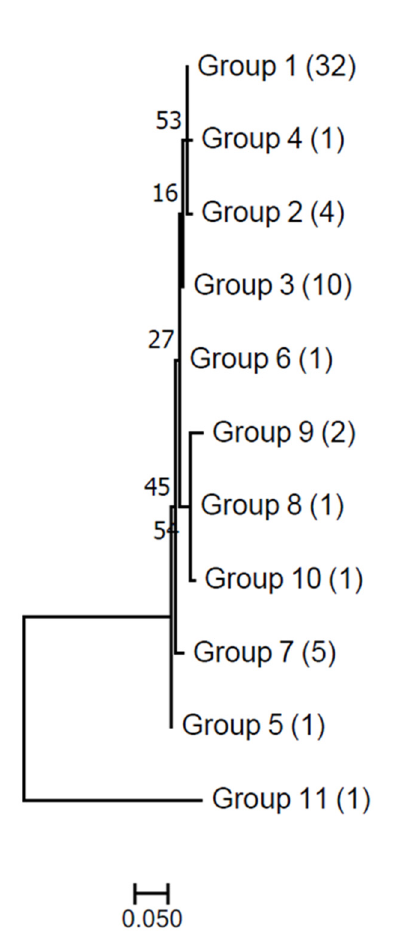
Figure 2. Phylogenetic tree of SASA domains of NanS-p proteins encoded by the 59 Stx phages included in the present study. Identical sequences were grouped and the molecular analysis involved 11 representative sequences. The evolutionary history was inferred by using the maximum likelihood method. Numbers in parentheses indicate the number of identical sequences in each group. Amino acid differences were concentrated at nine positions, except for one highly dissimilar sequence (group